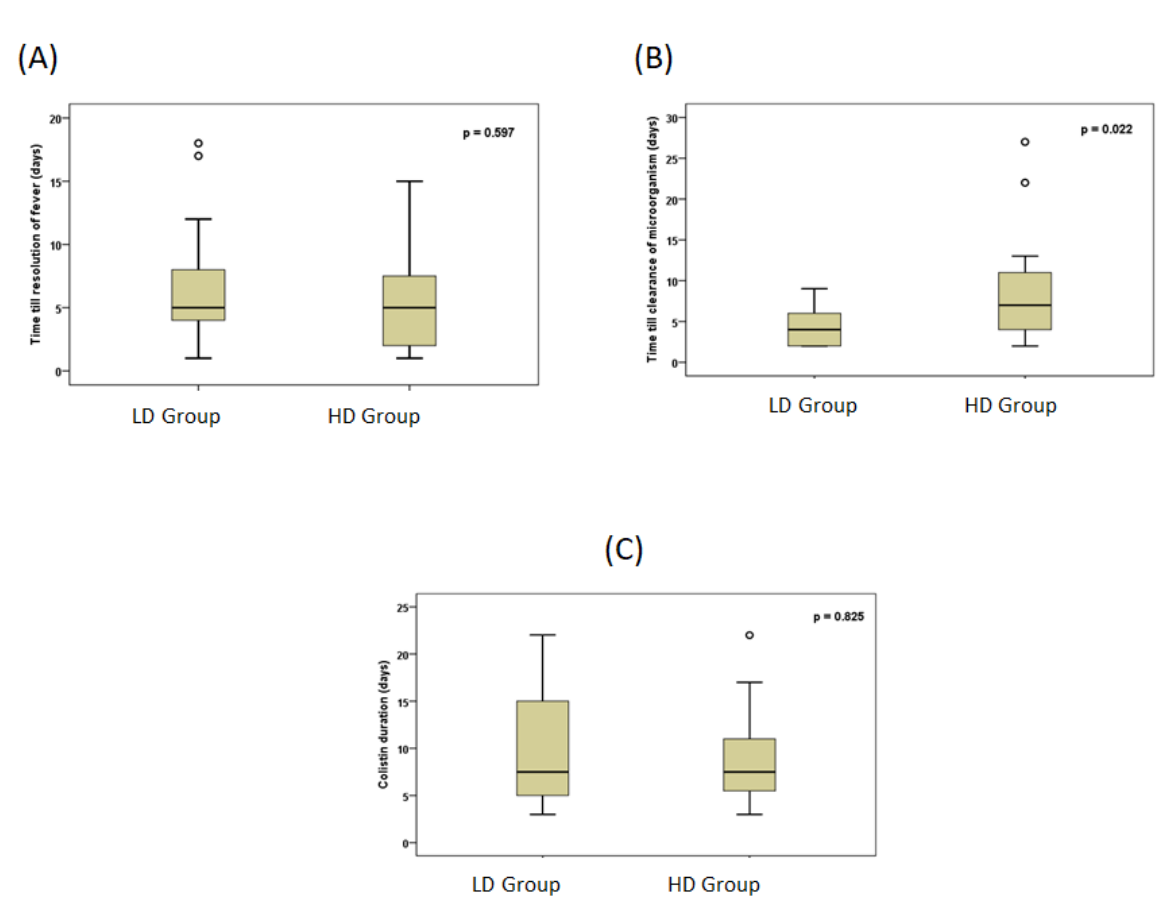
Fig. 2. Box plot presenting different outcomes in both 2.5 mg/kg/day (LD group) and 5 mg/kg/day (HD group), A. days till fever resolution, B. days till microbiological clearance, C. colistin